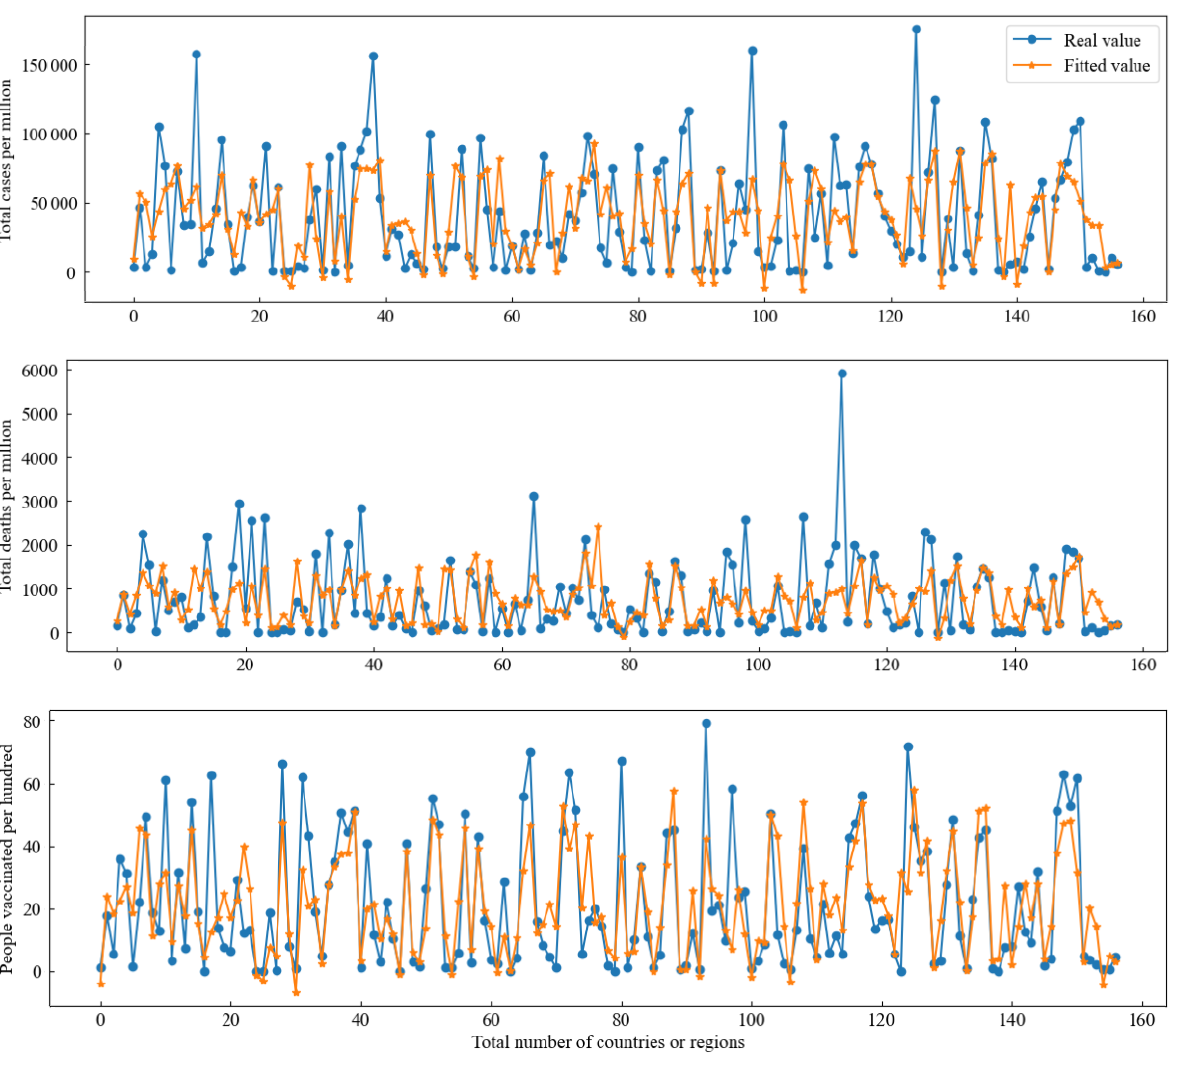
Fig. 8 Comparison of fitted and real values of TCPM, TDPM, and PVPH based on multiple regression model. Only 157 countries and regions were selected for analysis mainly because of some missing